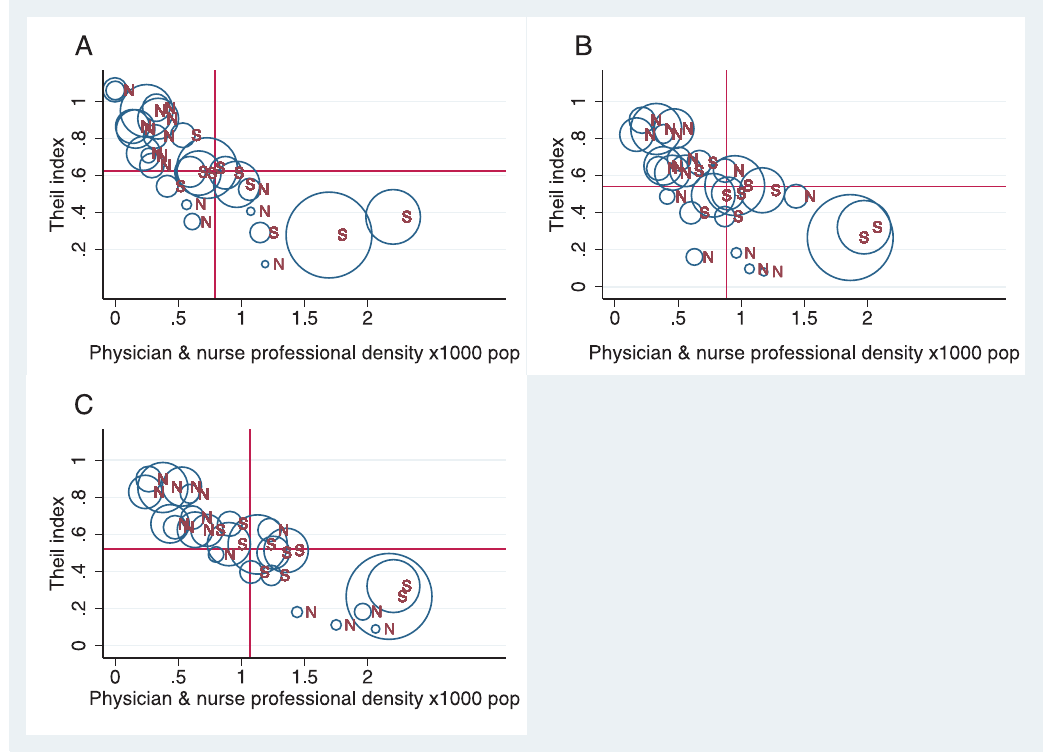
Figure 2. Relationship between the level of inequality and the density of physicians plus nurse professionals per 1000 pop by state and region in Brazil 1991–2005. Author’s calculation using data of the population Census 1991 & 2000 and Datasus 2005 -Conselhos profissionais (Ministe´rio da Sau´de/SGTES/DEGERTS/CONPROF). Note: X axis=density of physicians plus nurse professionals per 1000 pop. Y axis=Theil T index. Panel A=relationship for the year 1991. Panel B=relationship for the year 2000. Panel C=relationship for the year 2005. Each dot represents a state. The horizontal and vertical line represents the national averages of both variables. S refers to states in the Southern Regions and N refers to states in the Northern Regions. Area of the symbol proportional to state’s population.